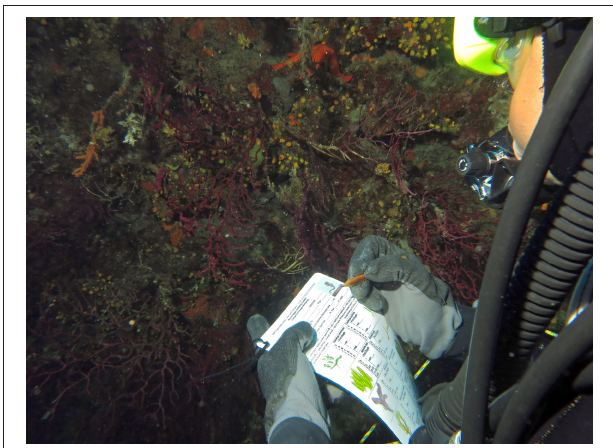
FIGURE 2 | Scuba diver recording data close to a rocky